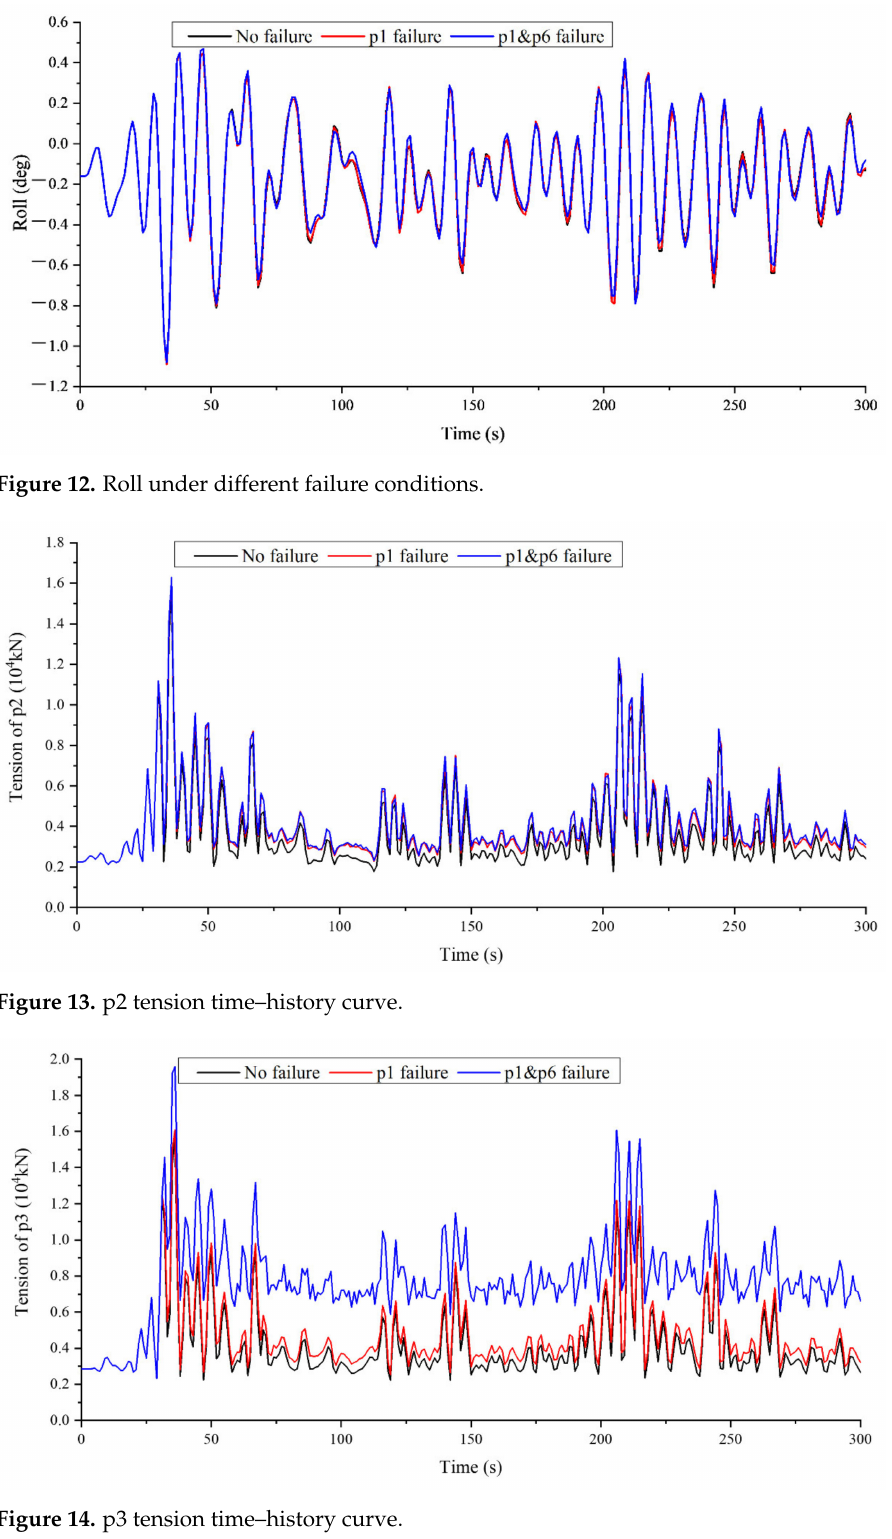
Figure 14. p3 tension time–history